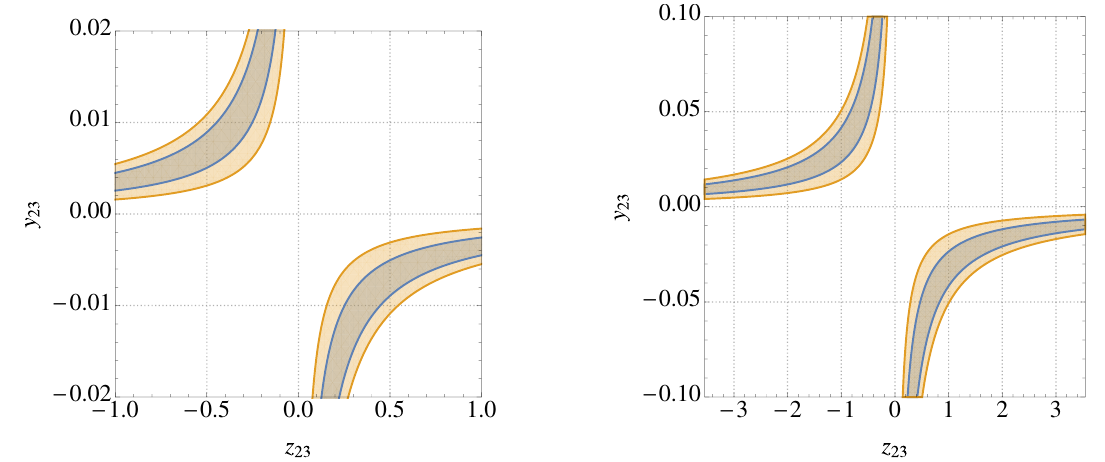
Figure 5. The 1 and 2 (cid:27) allowed regions for a m (cid:30) = 1 TeV (left) and m (cid:30) = 5 TeV (right). The top-mass enhancement in the (cid:12)rst term of eq. (3.11) allows the model to accommodate a